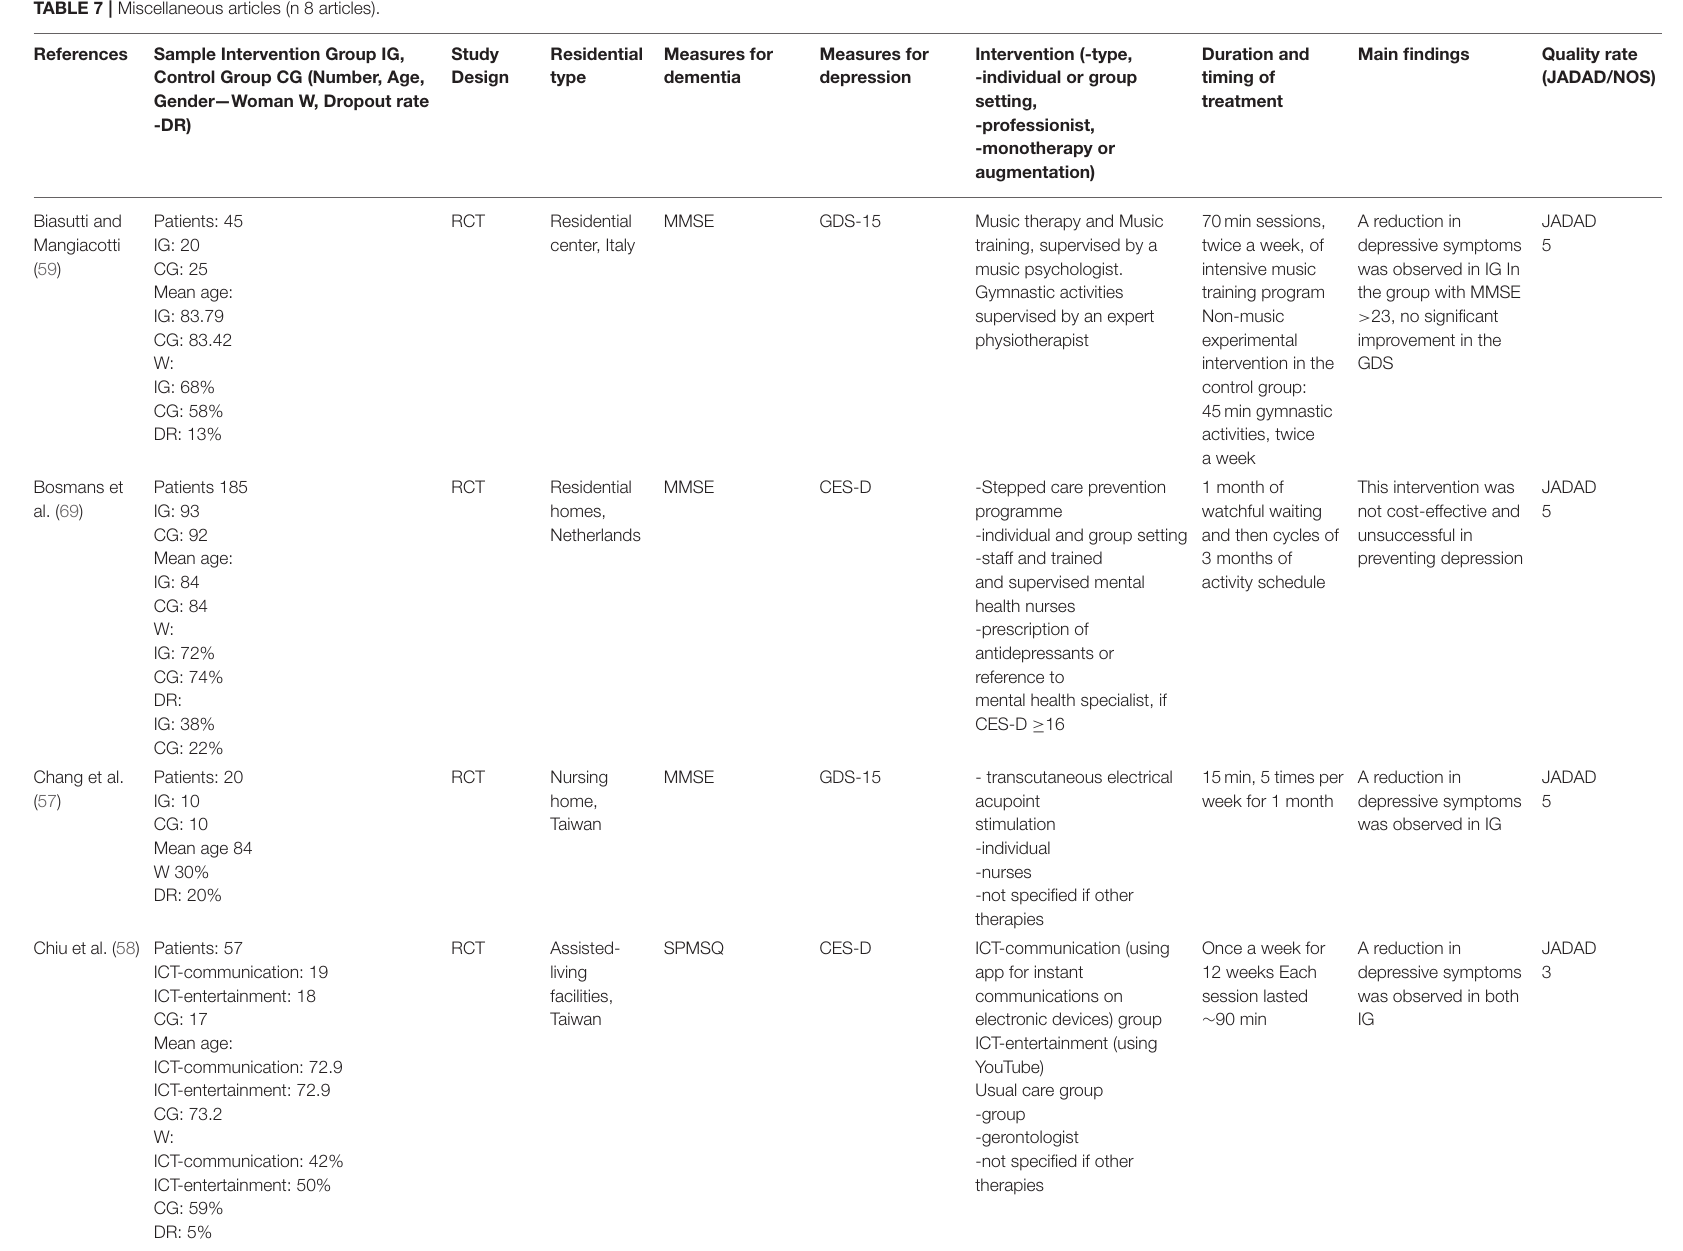
TABLE 7 | Miscellaneous articles (n 8